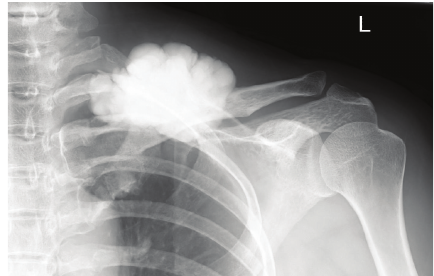
Figure 1: Radiographs reveal a well-defined, lobed mass in the midportion of the clavicle.